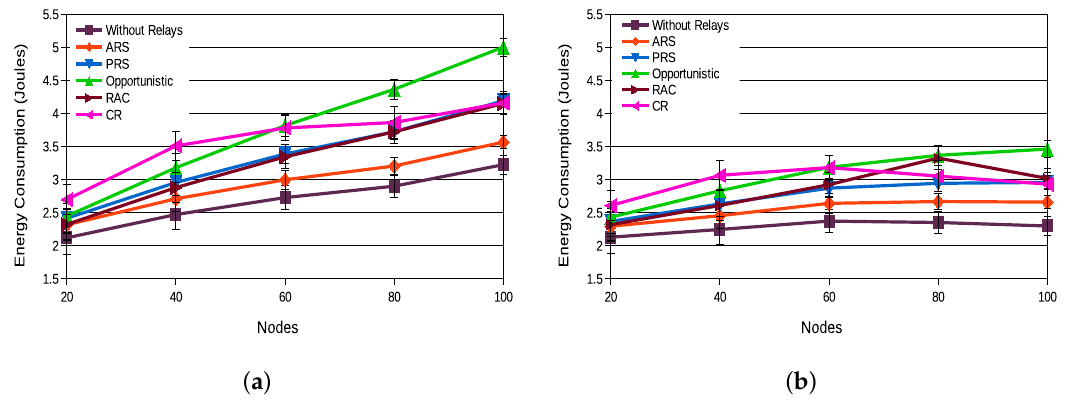
Figure 11. Energy consumption—static topology ( a ) vs. dynamic topology ( b ).